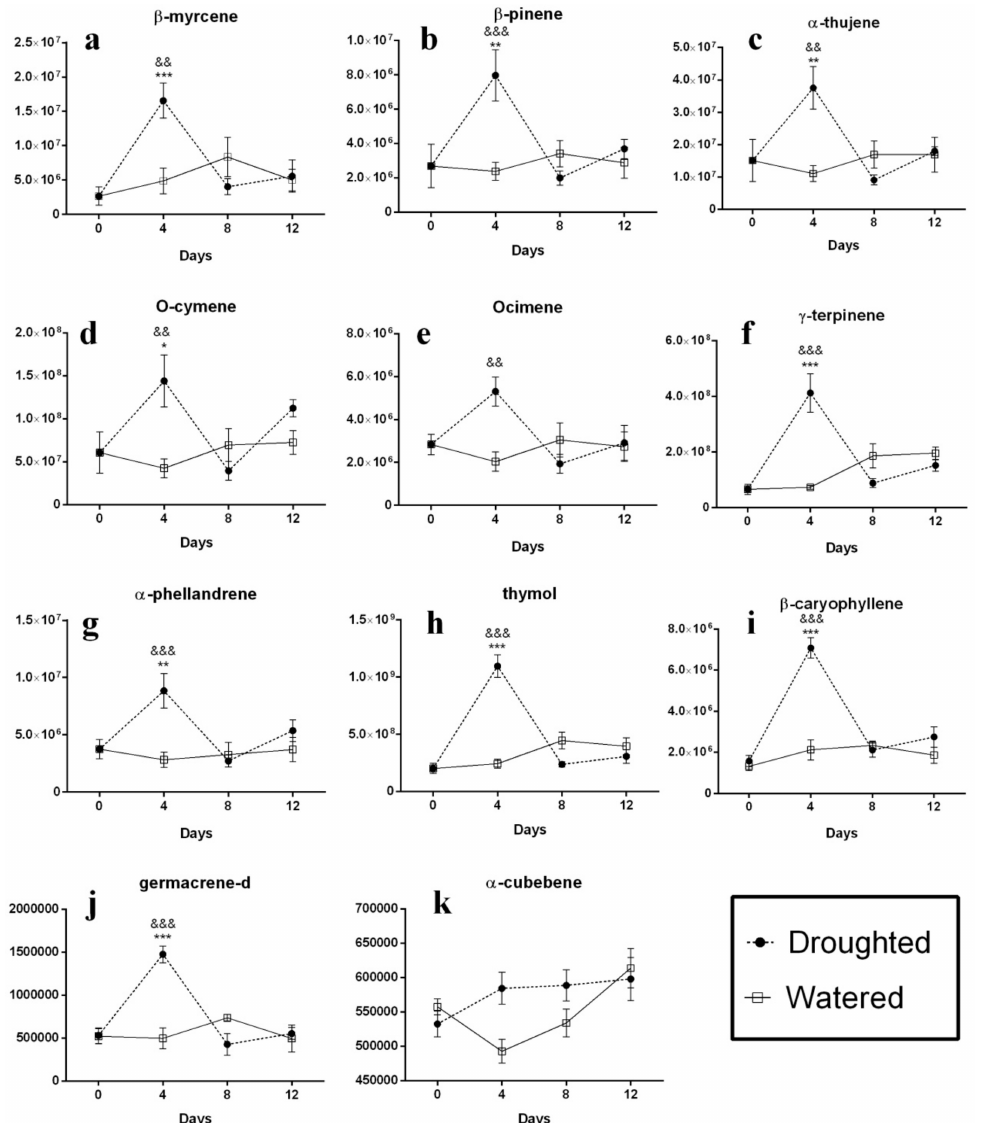
Figure 2. Profile of the changes of the volatile compounds in the leaves of the sensitive thyme plants during drought stress. Following water withholding, the leaves were harvested and analysis of non-polar extracts was carried out by direct infusion Fourier transform ion cyclotron resonance (DIFT-ICR) mass spectrometry. Vertical axis is the relative value of the compounds and horizontal axis the day of stress exposure. ( a ) β -myrcene; ( b ) β -pinene; ( c ) α -thujene; ( d ) O-cymene; ( e ) ocimene; ( f ) γ -terpinene; ( g ) α -phellandrene; ( h ) thymolo; ( i ) β -caryophyllene; ( j ) germacrene-d; ( k ) α -cubebene. * p < 0.05 vs. day 0 of Droughted group; ** p < 0.01 vs. day 0 of Droughted group, *** p < 0.001 vs. day 0 of Droughted group; & p < 0.05 Droughted vs. Watered group; && p < 0.01 Droughted vs. Watered group; &&& p < 0.001 Droughted vs. Watered group. Data are expressed as the mean ± S.E.M. Two-way ANOVA followed by the Sidak’s multiple comparisons test was